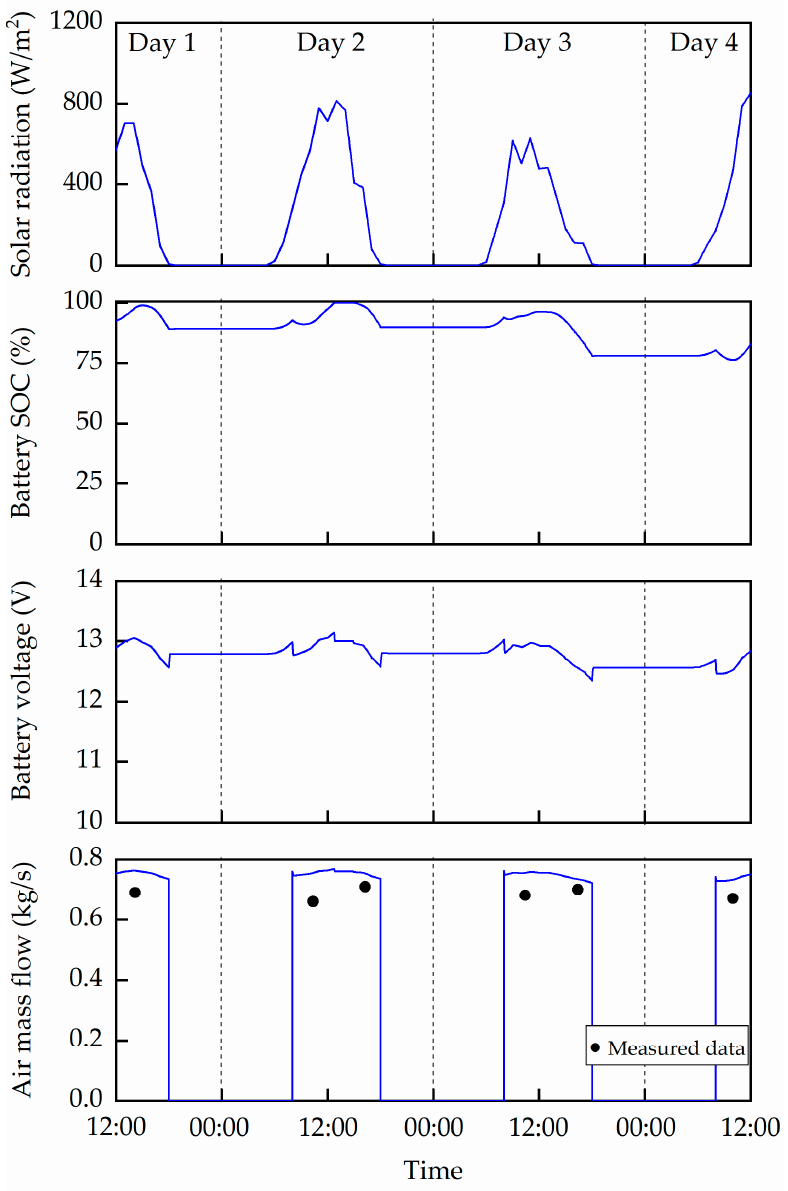
Figure 3. State-of-charge (SOC) and voltage of battery and air mass flow of an inflatable solar dryer (ISD) with two 100 W p PV modules and a 912 Wh battery, estimated for solar radiation data of Nairobi, together with measured data for air mass flow (data points), Kenya, on 8–11 December 2016.